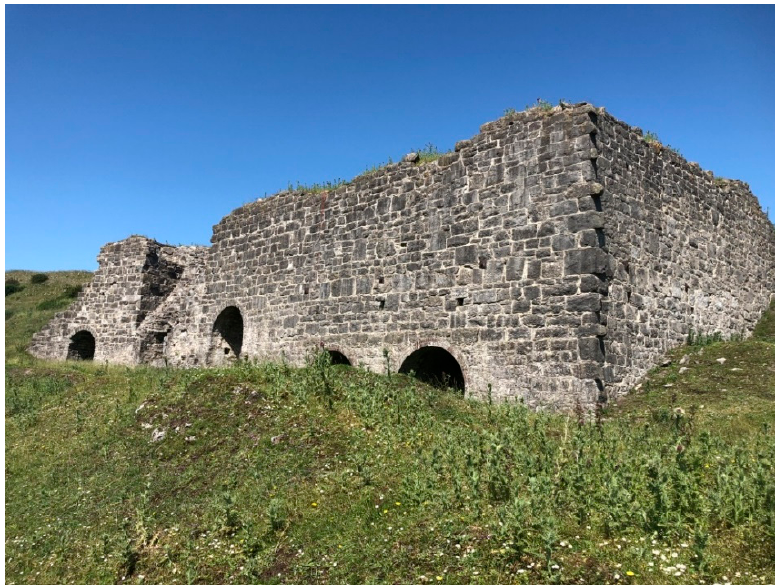
Figure 4. Waen-y-Brodlas limekilns, Halkyn Mountain. Photo © Mark Nuttall.